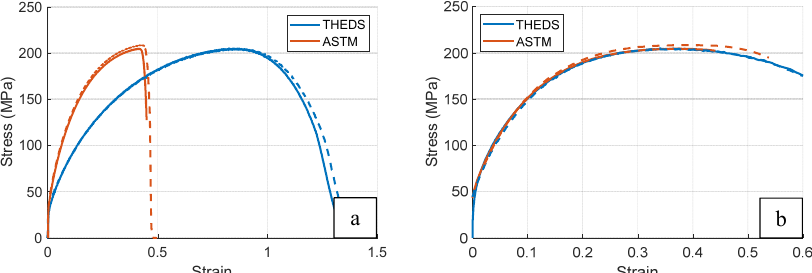
Fig. 4. Copper stress-strain (engineering) curves at 0.001 s -1 obtained elaborating a) MTS cross-head displacement and b) computing strains with DIC